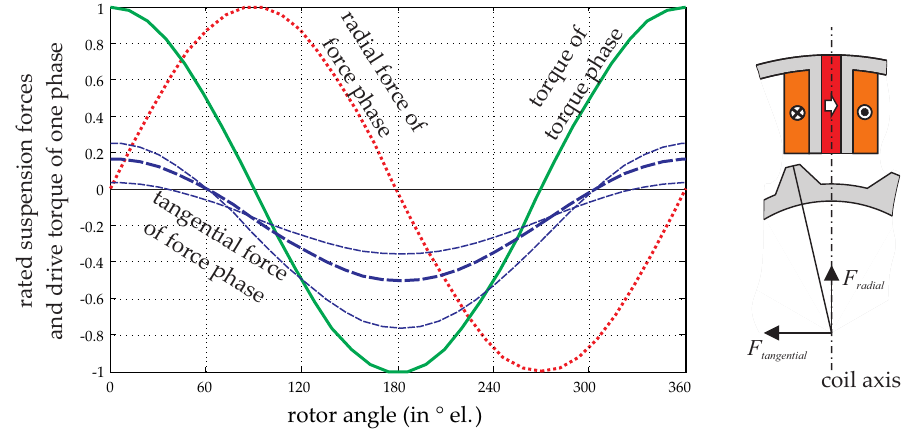
Figure 8. Single-phase torque and force characteristics of the linearized and decoupled bearingless flux-switching slice motor.